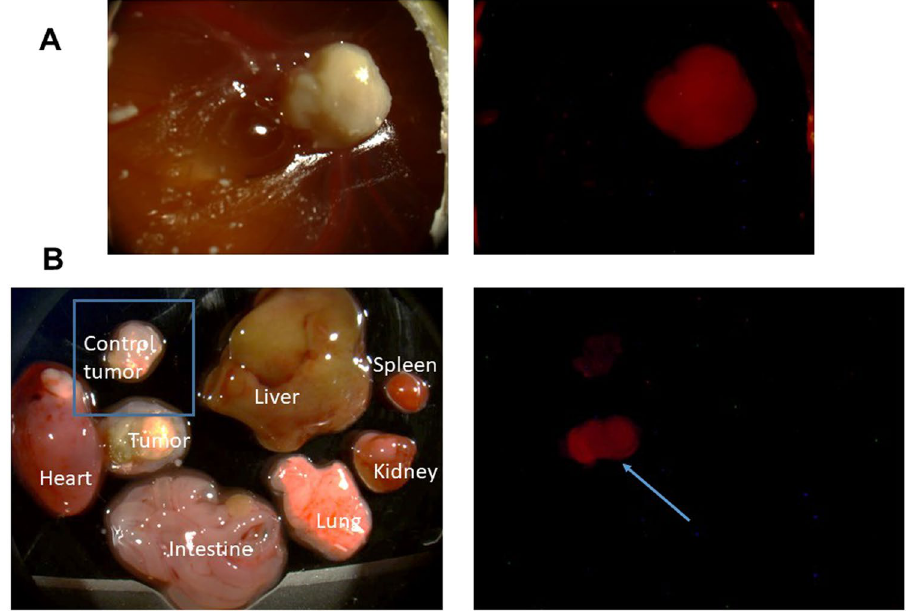
Figure 6. Tumor delivery of doxorubicin by nanoparticles. PMO-1 loaded with doxorubicin was intravenously injected and tumor delivery of doxorubicin was examined by following red fluorescence of doxorubicin ( A ). Internal organs were cut out and the presence of red fluorescence was examined ( B ).